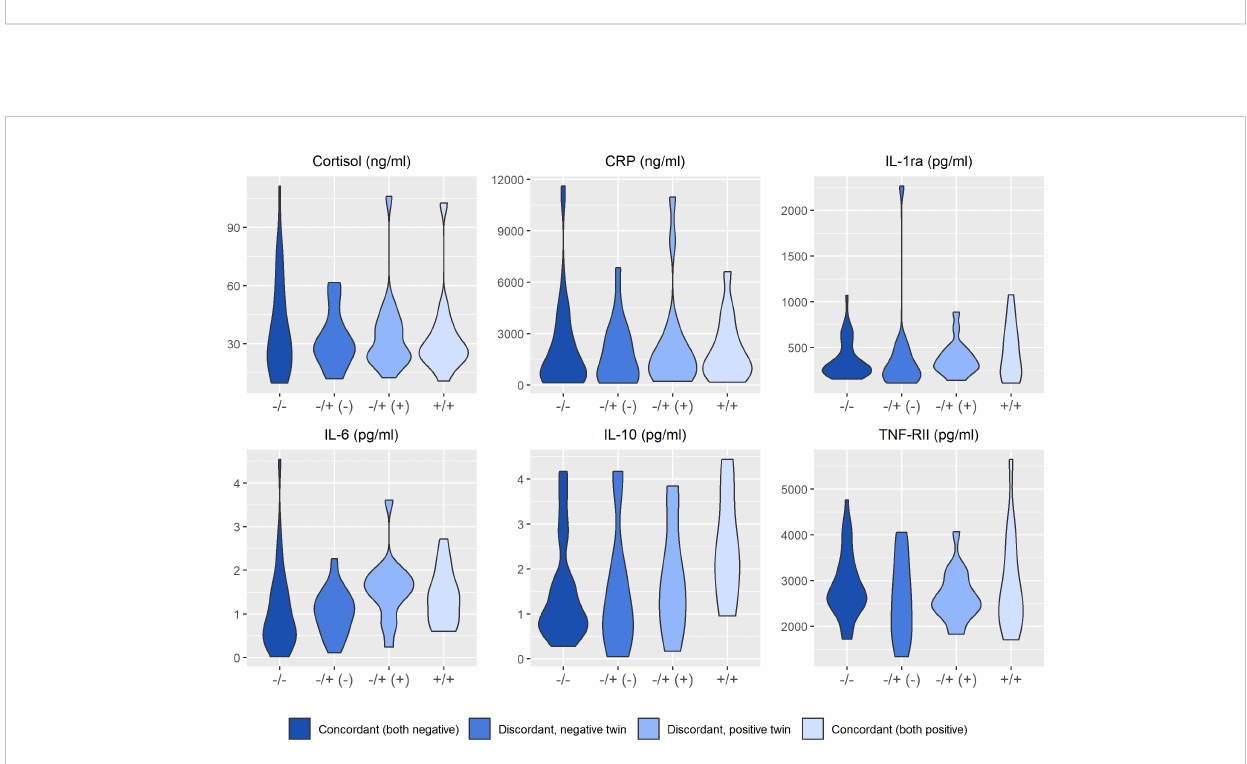
FIGURE 3 Distribution of immune markers arrayed by twin concordance for lifetime history of Major Depression (MD). Distribution of immune indicators by twin concordance for MD as assessed by the Diagnostic Interview Schedule. Units of the Y-axis for each indicator are shown in the subheading above each plot. Each plot is limited to the 42 twin pairs that were con fi rmed to be monozygotic using genetic testing. Sample size for each group shown in the legend: N Corcordant (both do not have MD) = 16 twin pairs (32 individuals), N Discordant for MD (-) = 19 twin pairs (19 individuals), N Discordant for MD (+) = 19 twin pairs (19 individuals), and N Corcordant (both have MD) = 7 twin pairs (14